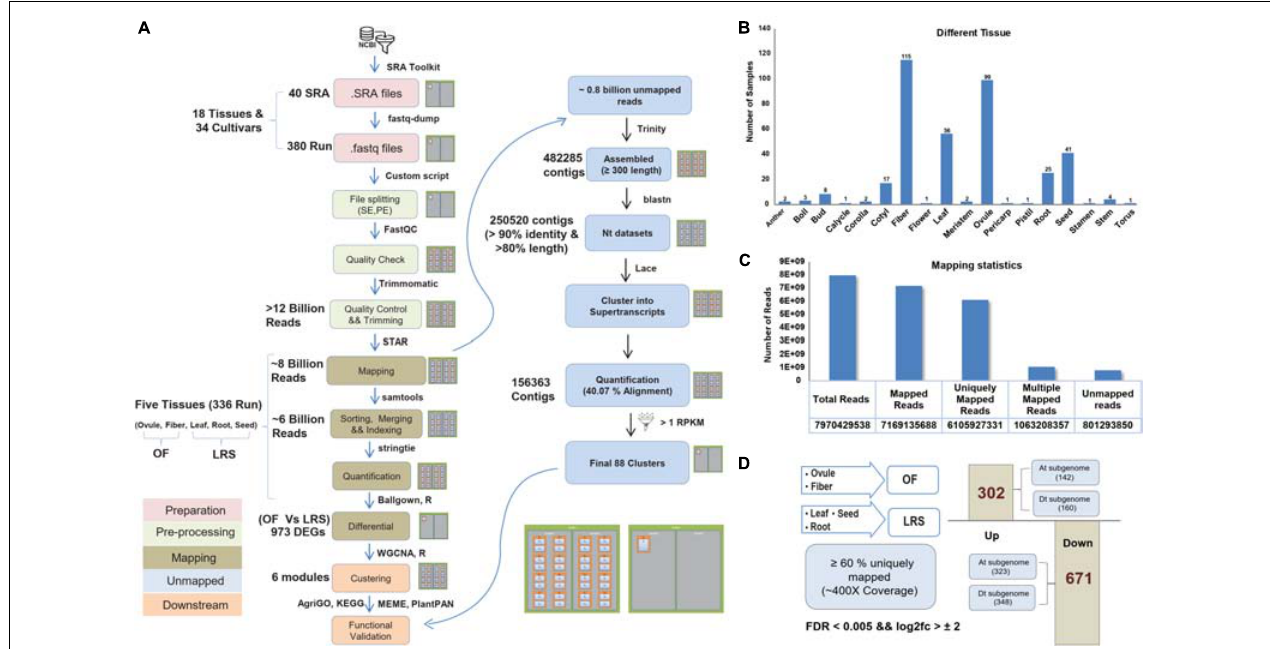
FIGURE 1 | Processing of RNAseq data and their mapping statistics. (A) The complete pipeline was used to analyze the Sequence Read Archive (SRA) files on High Performance Computing (HPC) facility. (B) Different numbers of processed RNAseq samples of different eighteen cotton tissues. (C) Mapping statistics of five selected tissues, including the total number of reads, uniquely mapped reads, and unmapped reads. (D) Differential estimation of uniquely mapped reads of OF and LRS tissues. OF tissue spans ovule and fiber uniquely mapping reads, while LRS tissue consists of uniquely mapped reads of leaf, root, and seed tissues. About 302 genes were assigned as upregulated differentially expressed genes (DEGs), and 671 represented as the downregulated